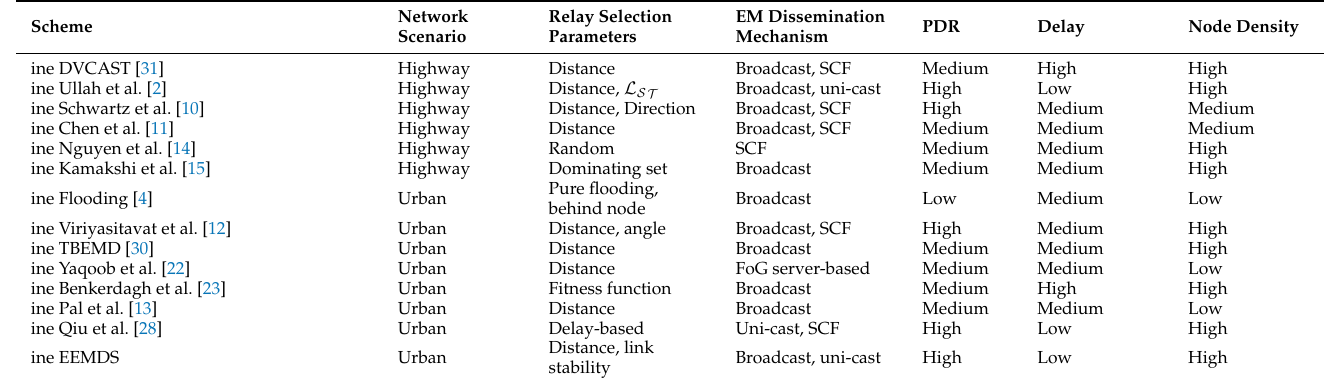
Table 1. Comparison of VANET EM dissemination schemes.